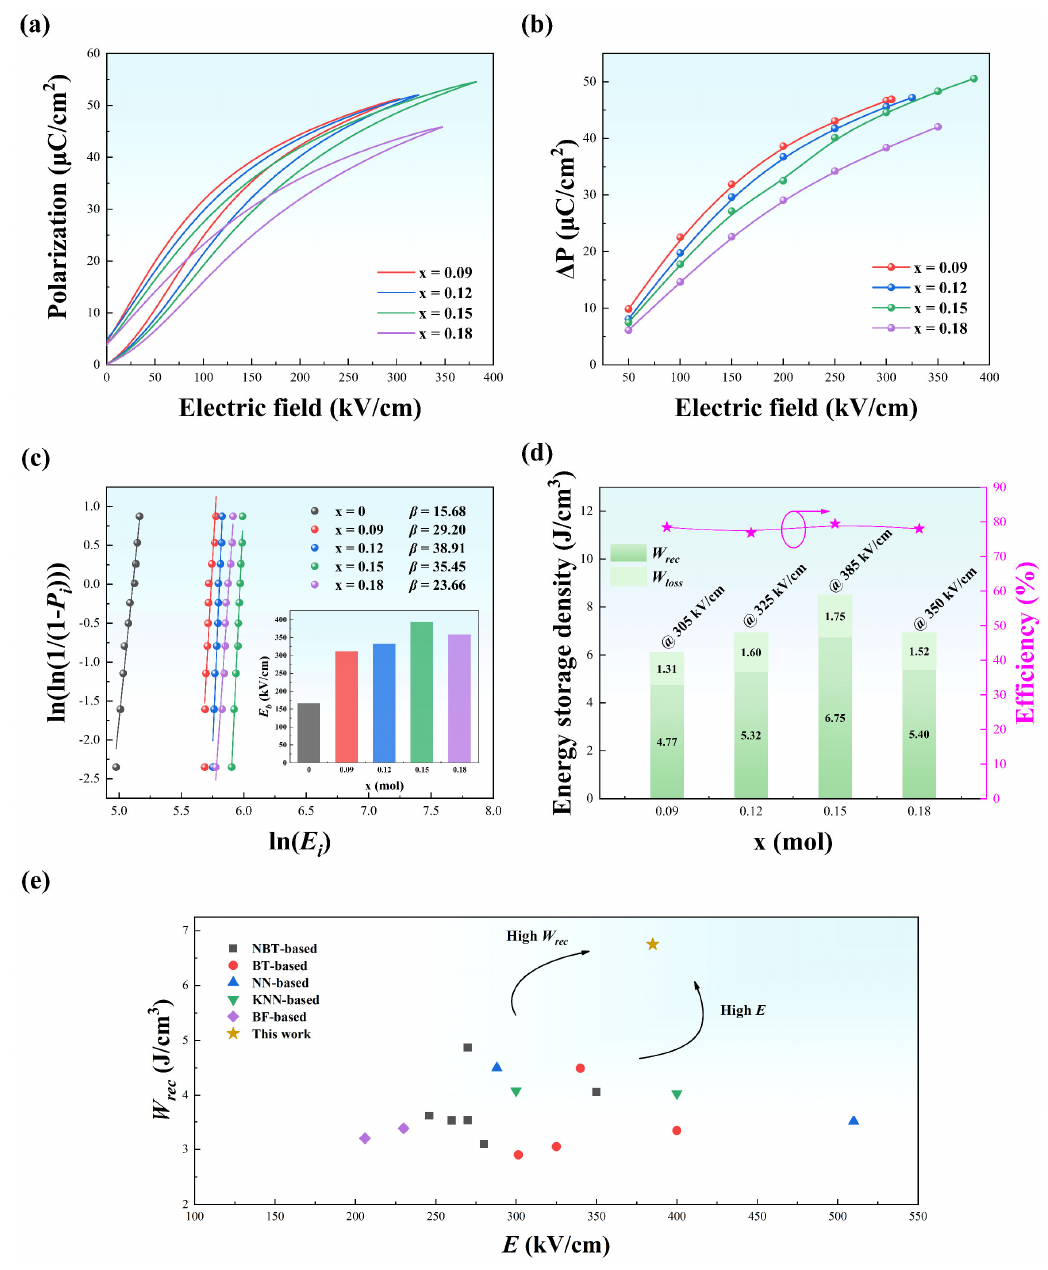
Figure 5. ( a ) Unipolar P-E loops at 100 Hz under various electric field; ( b ) the corresponding ∆ P of ( a ); ( c ) the Weibull distribution; ( d ) the corresponding ESP of ( a ) for various composition of NBT-SBT-xBMZ ceramics (x = 0.09, 0.12, 0.15, 0.18); ( e ) comparison of recoverable energy storage densities and applied electric fields for the sample of x = 0.15 and other lead-free ceramics reported. Pink star’s meaning has been defined by the right y -axis, where the arrow is